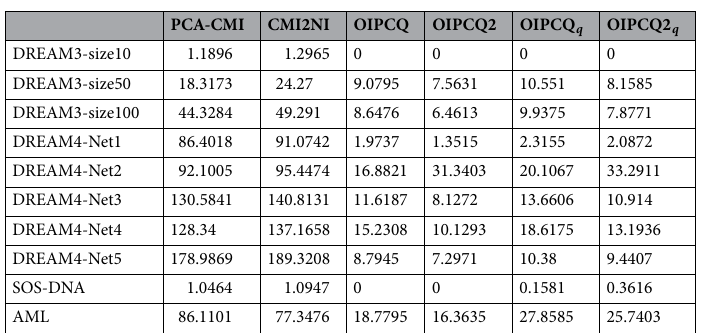
Table 7. Standard deviation for false positive based on different thresholds.